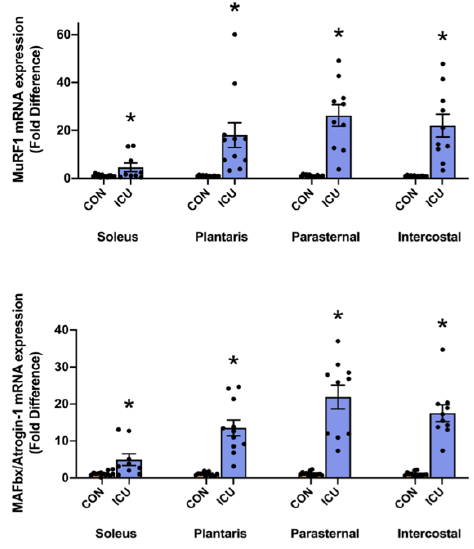
Figure 6. Ubiquitin-proteasome system. mRNA levels of the E3 ligases MuRF1 and MAFbx/Atrogin-1 in the soleus, plantaris, parasternal, and intercostal muscles of control, non-anesthetized, non-ventilated rats (CON), and rats that underwent 12 h of controlled mechanical ventilation (ICU). Data are presented as mean ± SEM. * significantly different versus CON ( p < 0.05).